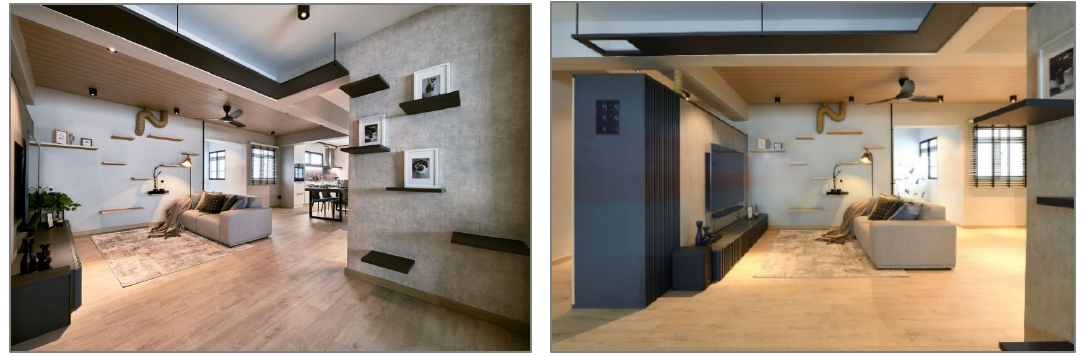
Figure 13 An Apartment designed by Mr Shopper Studio (URL-8)